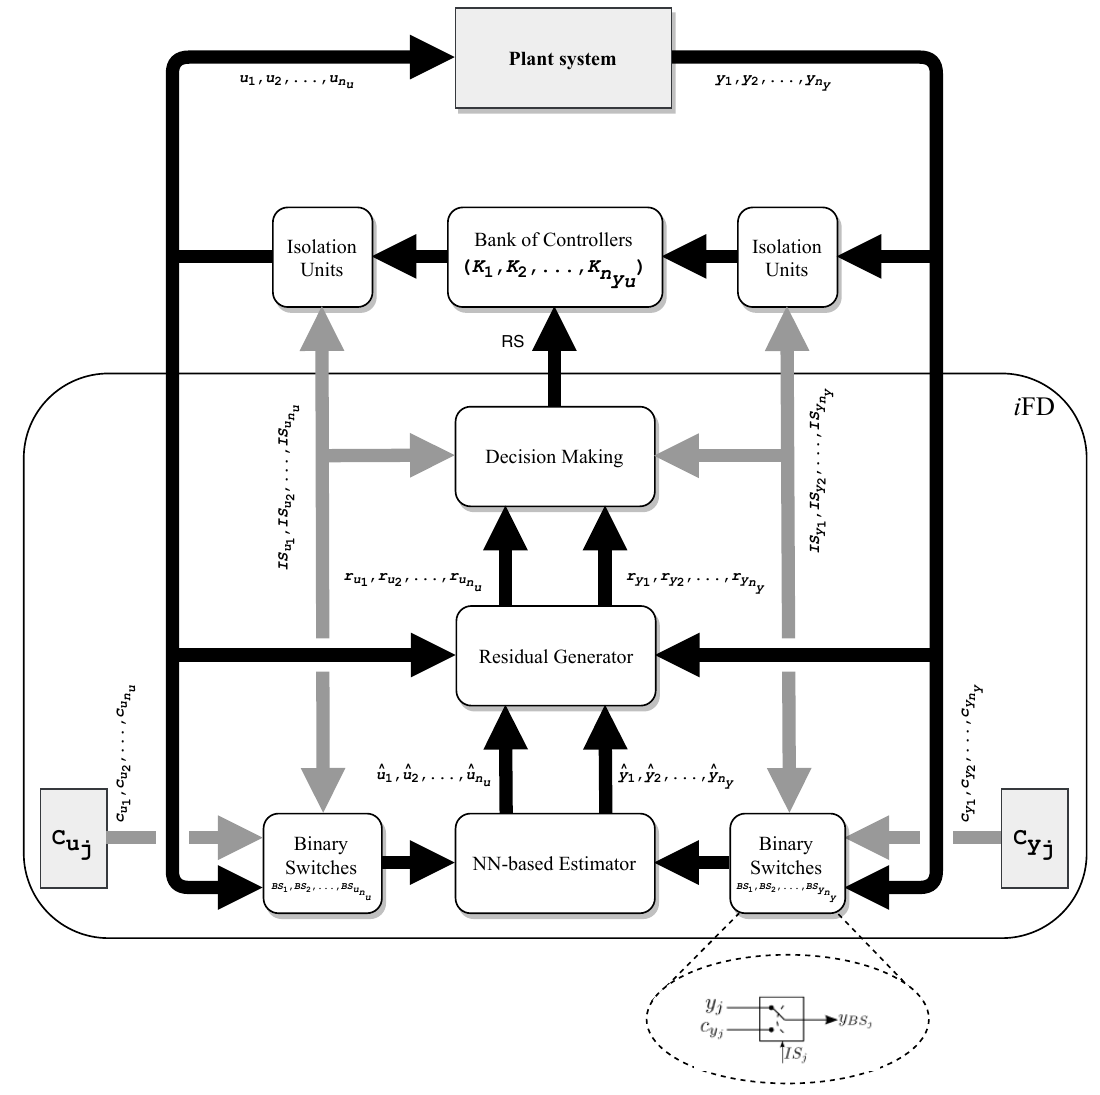
Figure 2. FDI general diagram with proposed i FD and including the binary switch